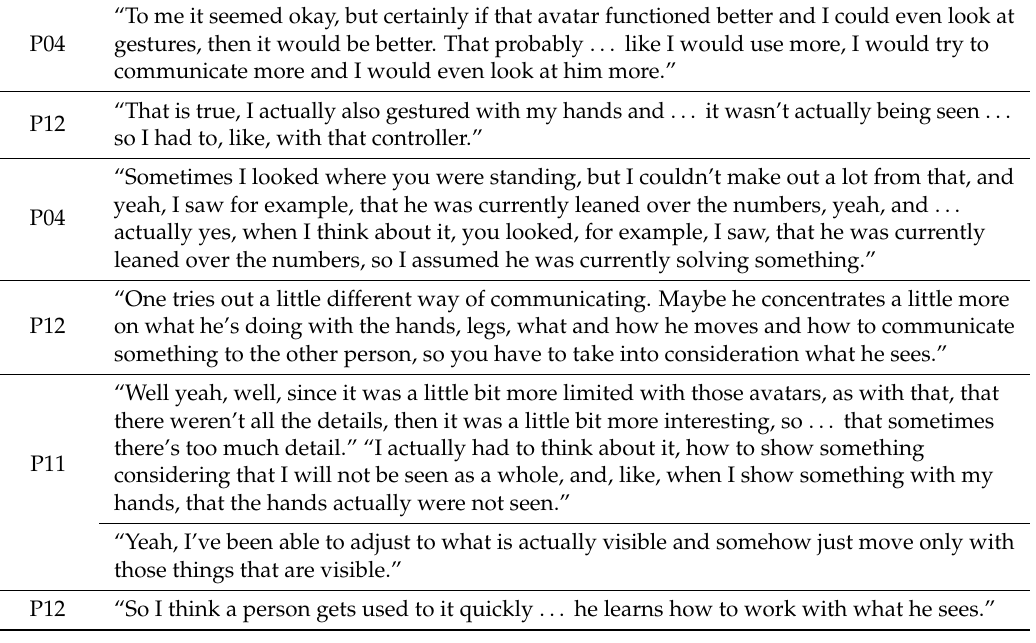
Table 6. Verbatim excerpts of statements by participants: Limited gestures via